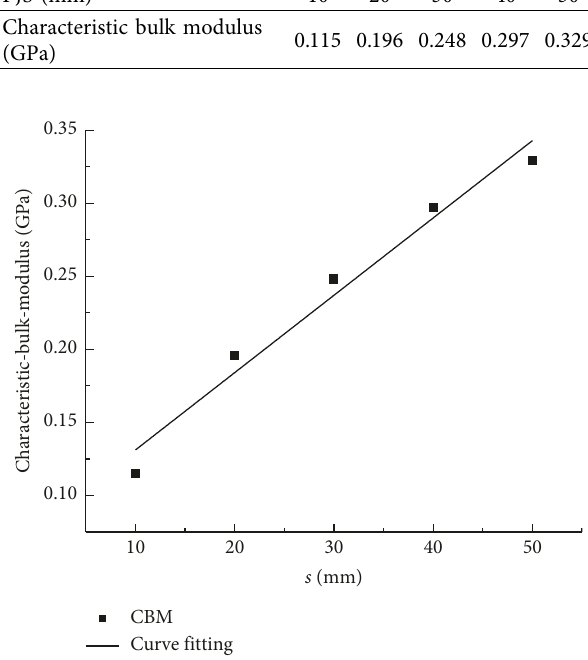
Figure 8: Fitting curve of CBM and PJS.